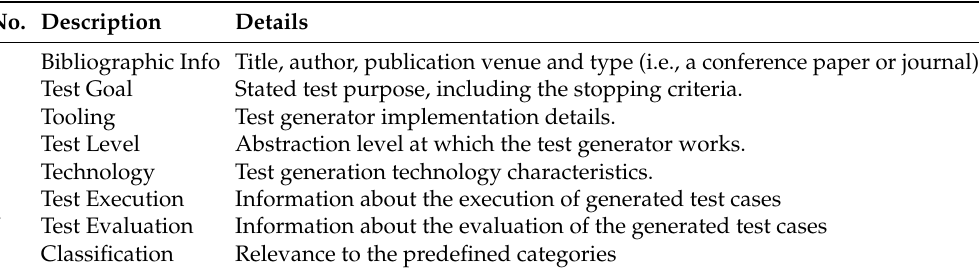
Table 1. Information about data extraction and